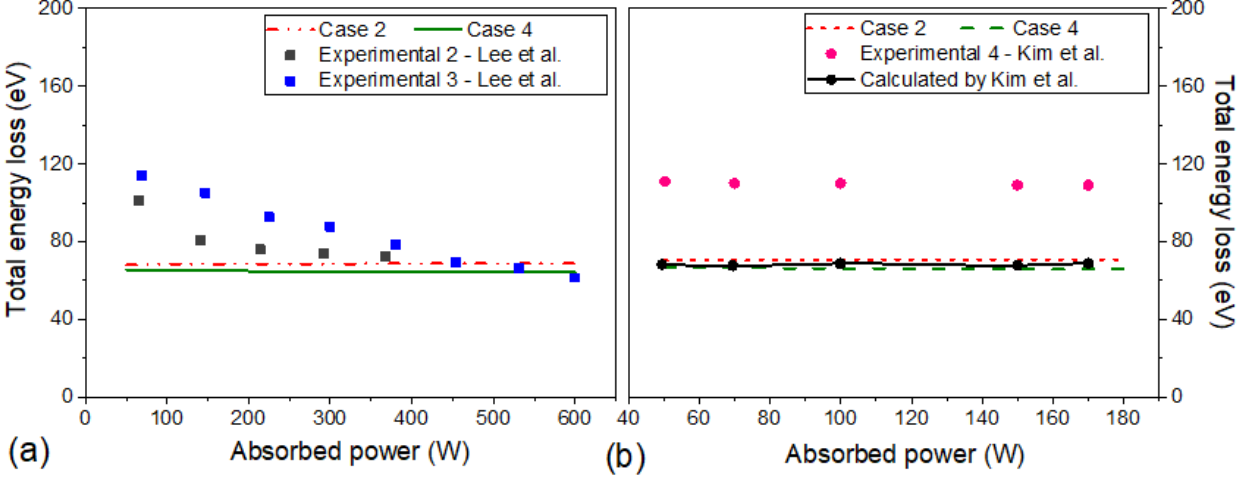
Figure 8. The total energy loss as a function of absorbed power at 10 mTorr for cases 2 and 4. In ( a ), the squares are experimental data of Lee et al. [33,34]. The simulations (lines) were performed with the input parameters: R = 19 cm, L = 30 cm, T g = 300 K and Q = 50 sccm at 10 mTorr. In ( b ), the circles are experimental data and calculated results of Kim et al. [36]. Here, the simulations (lines) were performed with the input parameters: R = 13 cm, L = 10 cm, T g = 300 K and 𝑄 = 15 sccm at 25 mTorr.